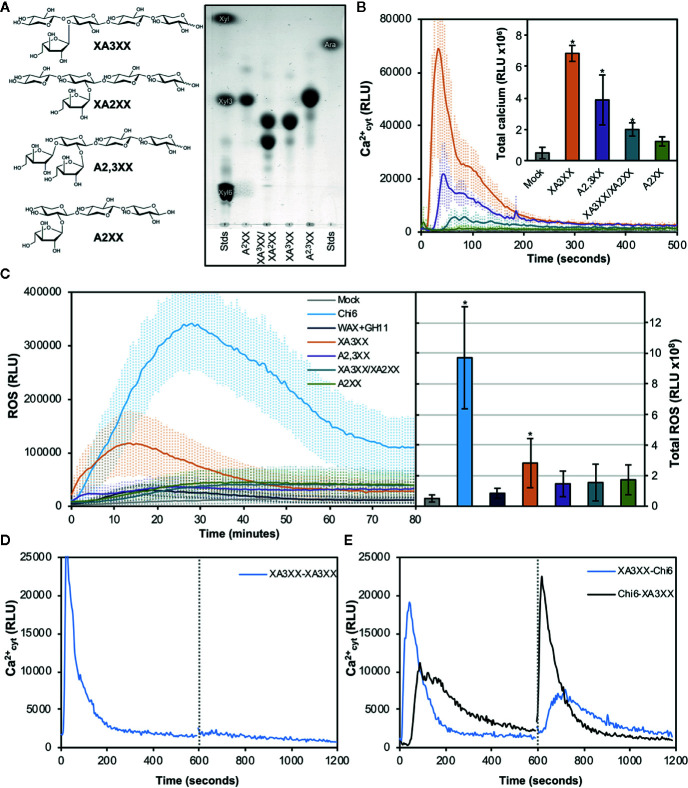
Pure arabinoxylan (AX) oligosaccharides trigger early immune responses in Arabidopsis. (A) Molecular structures of the different AX oligosaccharides used in the experiments. 33-α-L-arabinofuranosyl-xylotetraose (XA3XX), 23-α-L-arabinofuranosyl-xylotetraose (XA2XX), 23,33-di-α-L-arabinofuranosyl-xylotriose (A2,3XX), and 23-α-L-arabinofuranosyl-xylotriose (A2XX). Thin layer chromatography profiles of the pure commercial AXs used in the experiments using 1-propanol/ethyl-acetate/water (9:7:4 by volume) as mobile phase. Left and right lanes show xylose (Xyl), xylotriose (Xyl3), xylohexaose (Xyl6) and arabinose (Ara) which were used as markers. TLC shown is from one run representative of three independent ones with similar results. (B) Calcium influx measured as relative luminescence units (RLU) over the time in 8-d-old Arabidopsis Col-0AEQ seedlings after treatment with 500 μM of pure AX oligosaccharides. Water (mock) was used as negative control. The total areas-under-the-curves were integrated and their values are represented at the right side of the panel. Data represent mean ± SD (n=8) from one experiment representative of three independent ones with similar results. Statistically significant differences according to Student’s t-test (*p < 0.05) compared to negative control are shown. (C) Reactive oxygen species (ROS) production (by Luminol reaction) after treatment with 500 μM of pure AX oligosaccharides in Arabidopsis leaf-discs measured as RLU over the time. Water (mock), GH11-digested wheat AX before chromatographic purifications (WAX+GH11) and chitohexaose (Chi6; 100 μM) were used as negative (mock and GH11+WAX) and positive (Chi6) controls. The total areas-under-the-curves were integrated and their values are represented at the right side of the panel. Data represent mean ± SD (n=8) from one experiment representative of three independent ones with similar results. Statistically significant differences according to Student’s t-test (*p < 0.05) compared to water control are shown. (D, E) Cross elicitation during the refractory period of calcium signaling between XA3XX (250 μM) and chitohexaose (Chi6; 100 μM). Data show the elevation of cytoplasmic calcium concentration, measured as relative luminescence units (RLU), over the time in 8-d-old Arabidopsis Col-0AEQ seedlings after treatments. Dashed line (600 s) indicates the application time of the second elicitor within the refractory period of the first elicitation. In (E), blue line represents a first treatment of XA3XX followed by Chi6 after 600 s, while black line represents a first treatment with Chi6 followed by a second of XA3XX. Data represent mean (n=8) from one experiment representative of three independent ones with similar results.